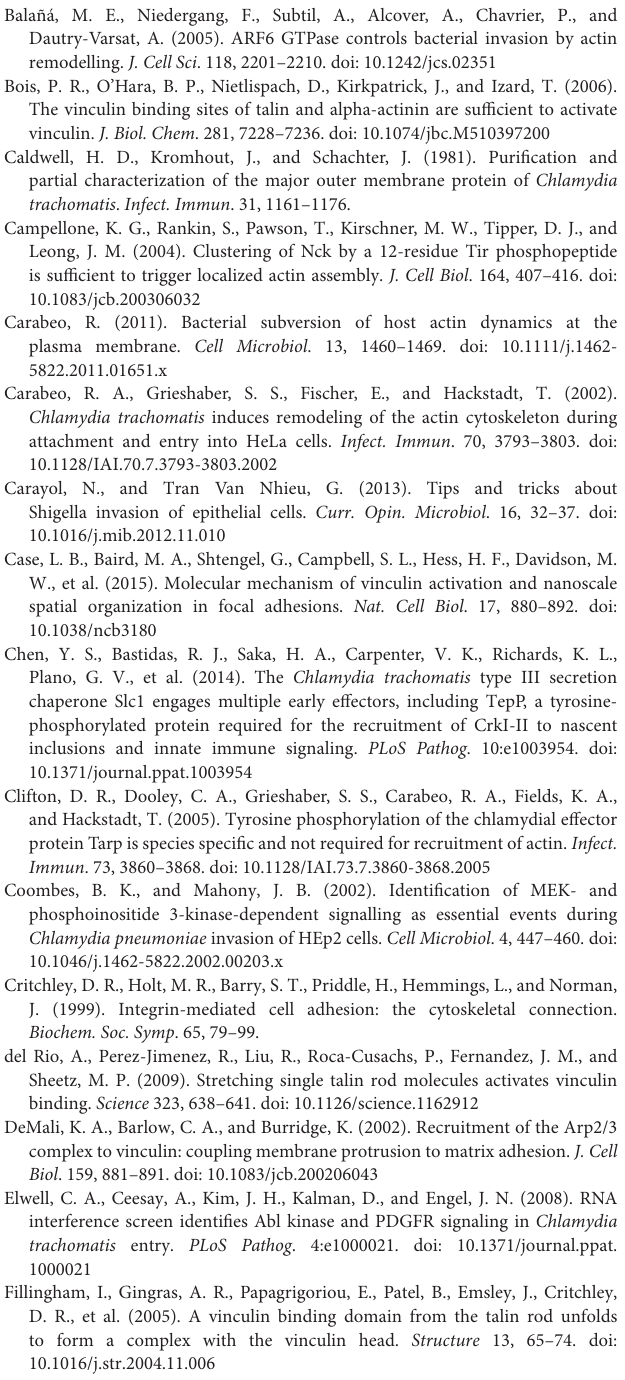
residues are in blue. (C) Schiffer-Edmundson helical wheel diagrams depicting the 19 amino acids of VBS1, VBS2, VBS3, mutant VBS1, and IpaA VBS1 created with DNAstar program demonstrating the possible amphipathic α -helical conformation. Helical wheel projects the arrangement of amino acids, and residue numbers are counted from the amino terminus. Amino acids are represented by the single letter